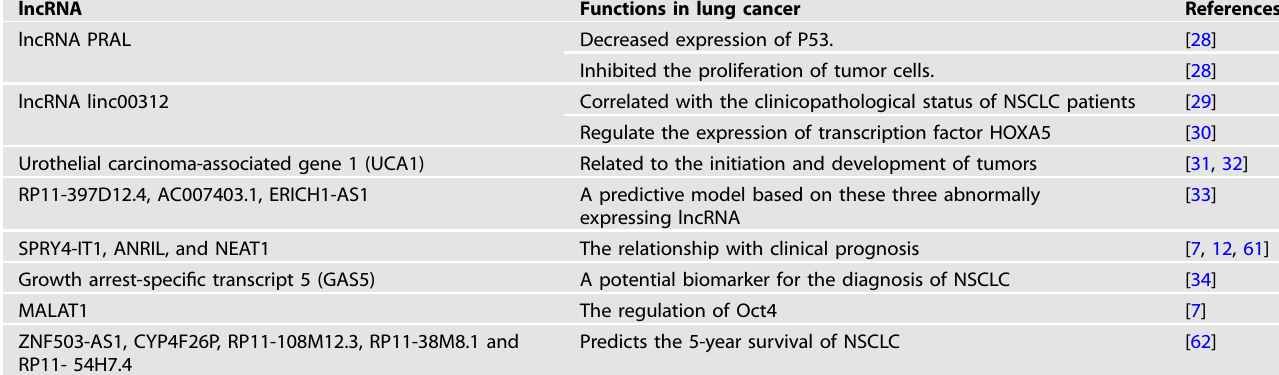
Table 1. Functions of different lncRNAs in lung